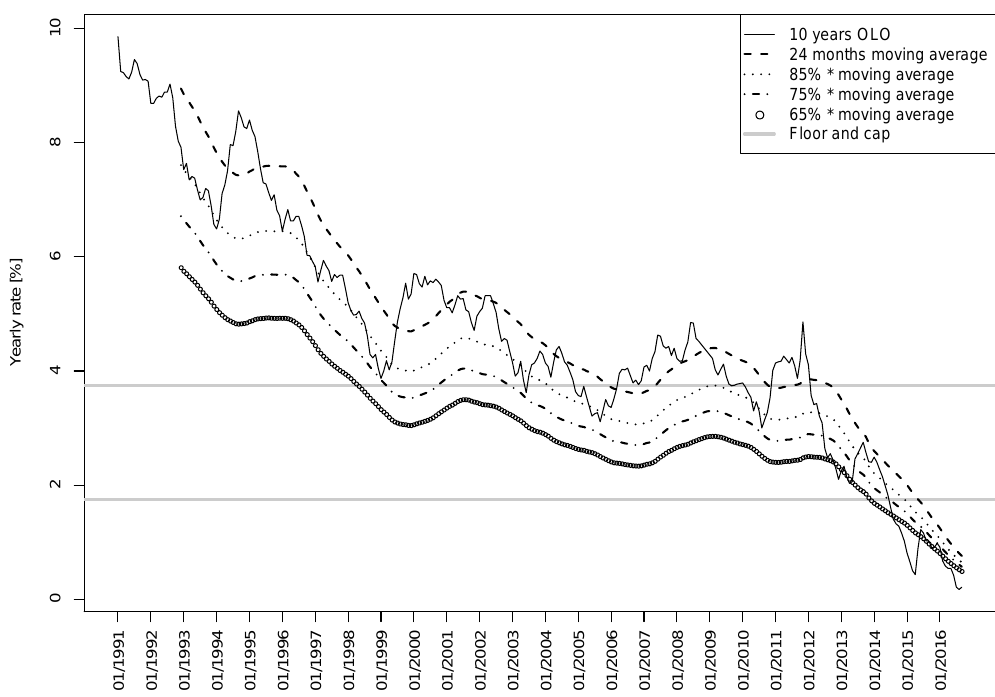
Figure 1. Different rates appearing in the definition of the reference rate.